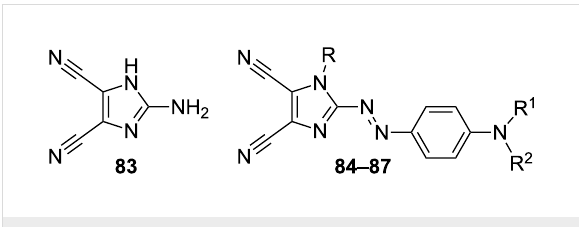
Figure 15: 4,5-Dicyanoimidazole-derived chromophores 84 – 87 [103- 106].